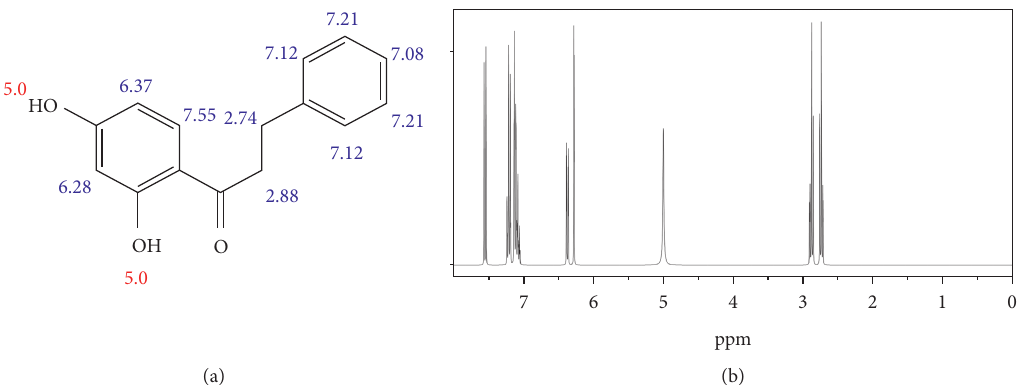
Figure 2: (a) Calculated spectrum and chemical structure of the flavonoid 2’,4 ′ -dihydroxydihydrochalcone and (b) 1H NMR spectrum of 2 ′ ,4 ′